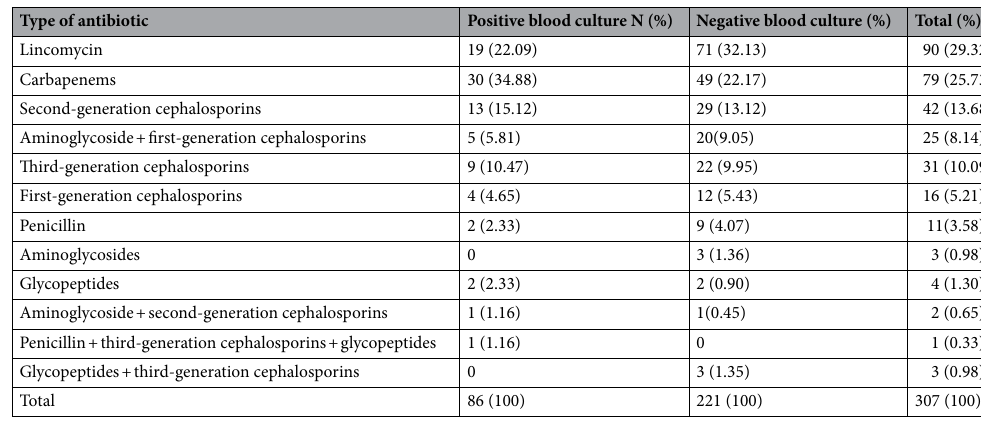
Table 6. Initial antibiotic therapy within 24 h after admission (n = 307).